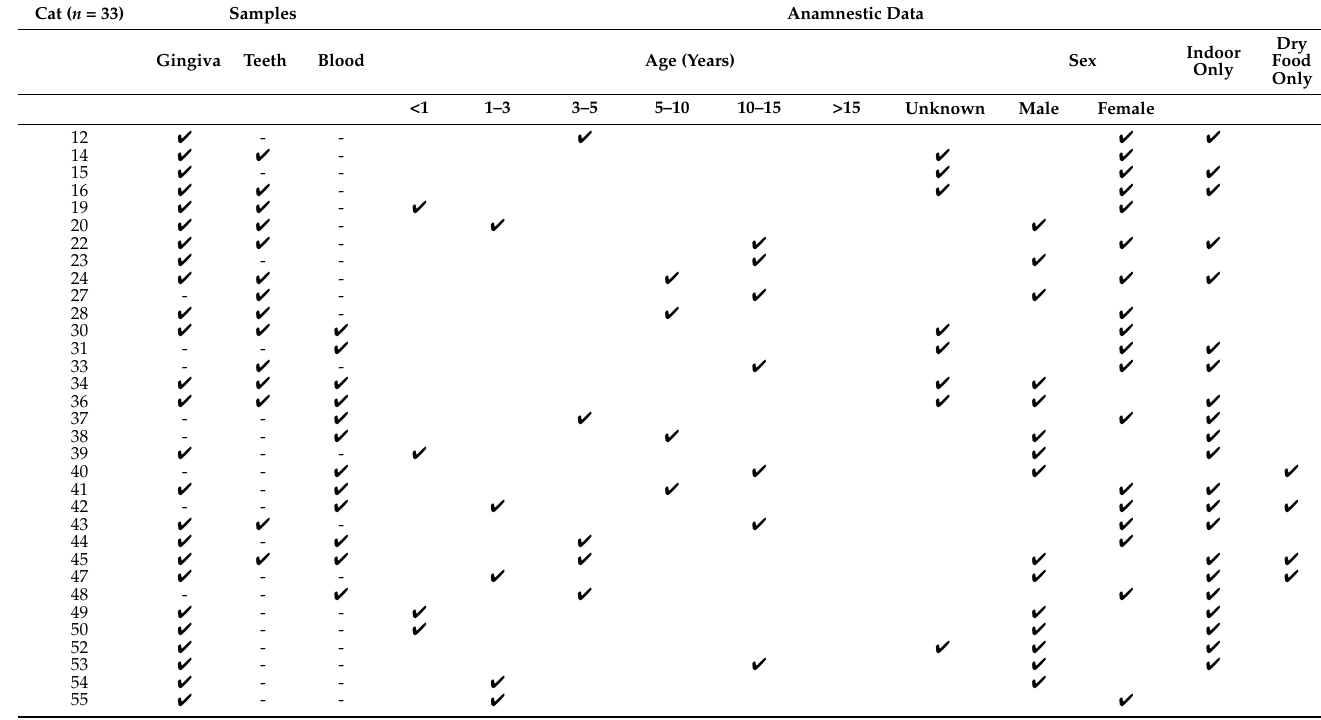
Table 2. Overview of the included cats. These cats had an appointment for routine dental treatment and were included in the study. An overview of the obtained samples, age, sex, indoor only and dry food only is given. Cat ( n = 33) Samples Anamnestic Data Gingiva